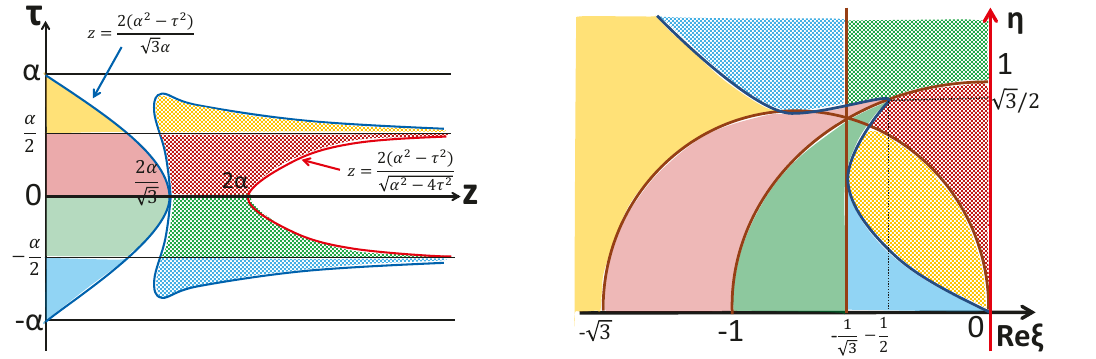
Figure 12 . The boundary surface Q + for T BCFT = 0 in the gravity dual of splitting local quench. The left picture describes in the coordinate ( w; (cid:22) w; z ) setting x = + (cid:14) ! 0. The right picture does in the Poincar(cid:19)e coordinate ( (cid:24); (cid:22) (cid:24); (cid:17) ) on the boundary Im[ (cid:24) ] = 0. The red curve in the left picture is mapped into the Re[ (cid:24) ] = 0 in the right one. The two blue curves in the left are pasted with each other in a way they are mapped into the blue curve in the right picture. The eight colored regions in the left are mapped into those in the right. Note that there are one more boundary surface corresponding to x = (cid:0) (cid:14) ! 0, which is given by the same structure and is mapped to the Re[ (cid:24) ] > 0 region. The white region in (cid:0) (cid:11) < (cid:28) < (cid:11) should also be removed to secure the map is one to 2 2